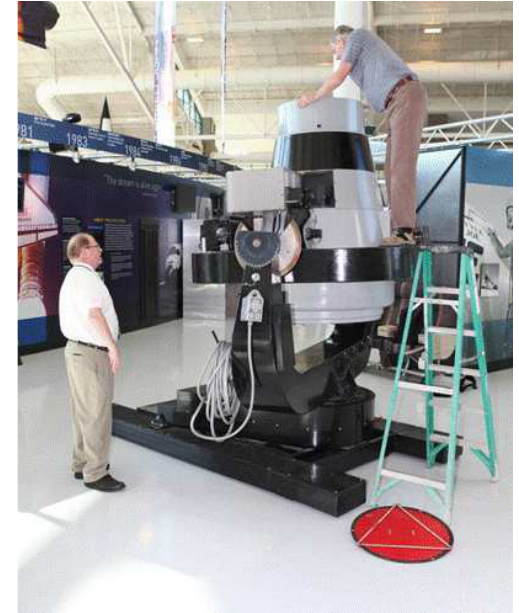
Dismantling of the USAF Baker–Nunn camera at the Evergreen Aviation & Space Museum,